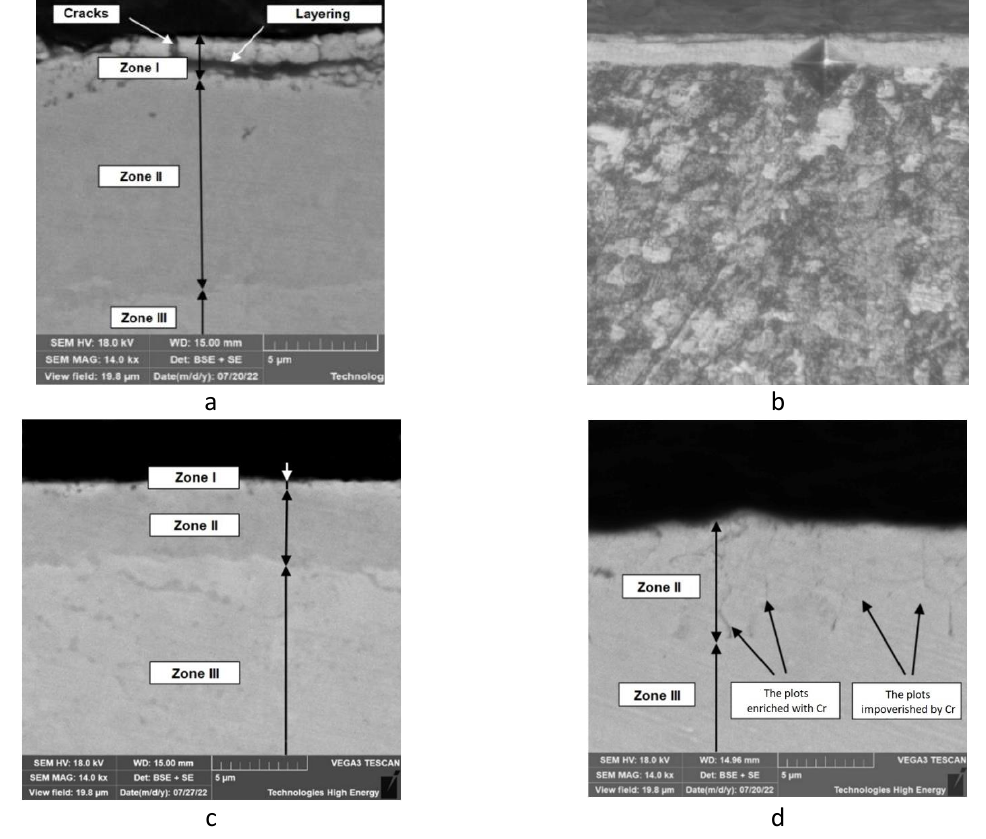
Fig. 3. Electronic pictures of the sample surface after nitriding: a, b - sample №1 by the first technology, c - sample №2 by the second technology, d - sample №3 by the third